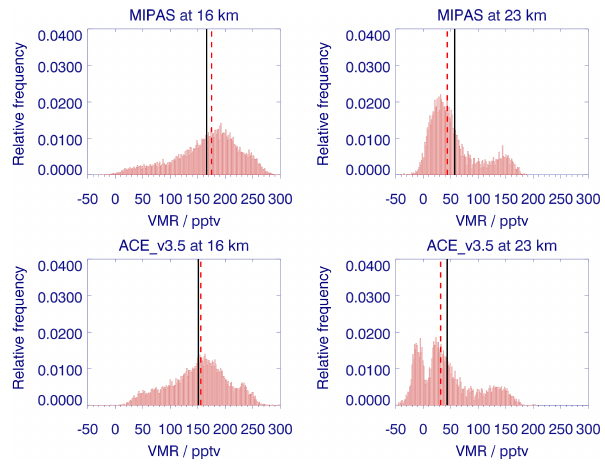
Figure 10. Histogram of MIPAS CFC-11 measurements (top pan- els) and ACE-FTS measurements (bottom panels) for the years 2005–2012 at 16km (left panels) and 23km (right panels). The black line indicates the location of the mean of the sample, while the red dashed line marks the